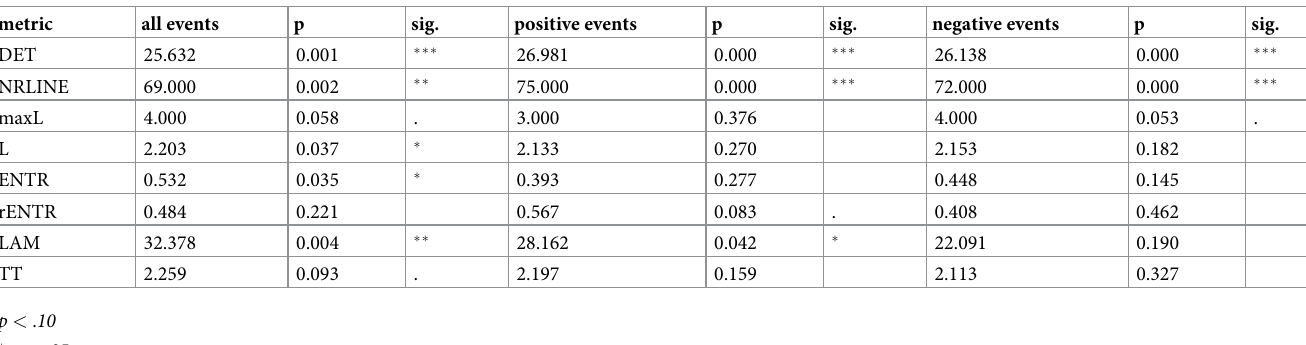
Table 4. CRQA results for original tweets and source-target data. metric all events